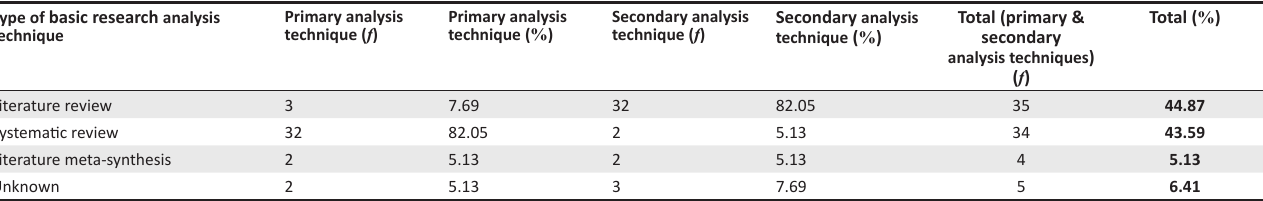
TABLE 11: Basic research-analysis